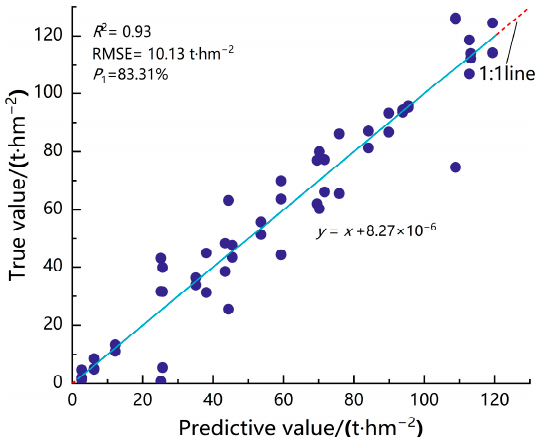
Figure 7. Optimized random forest AGB model-fitting accuracy map.